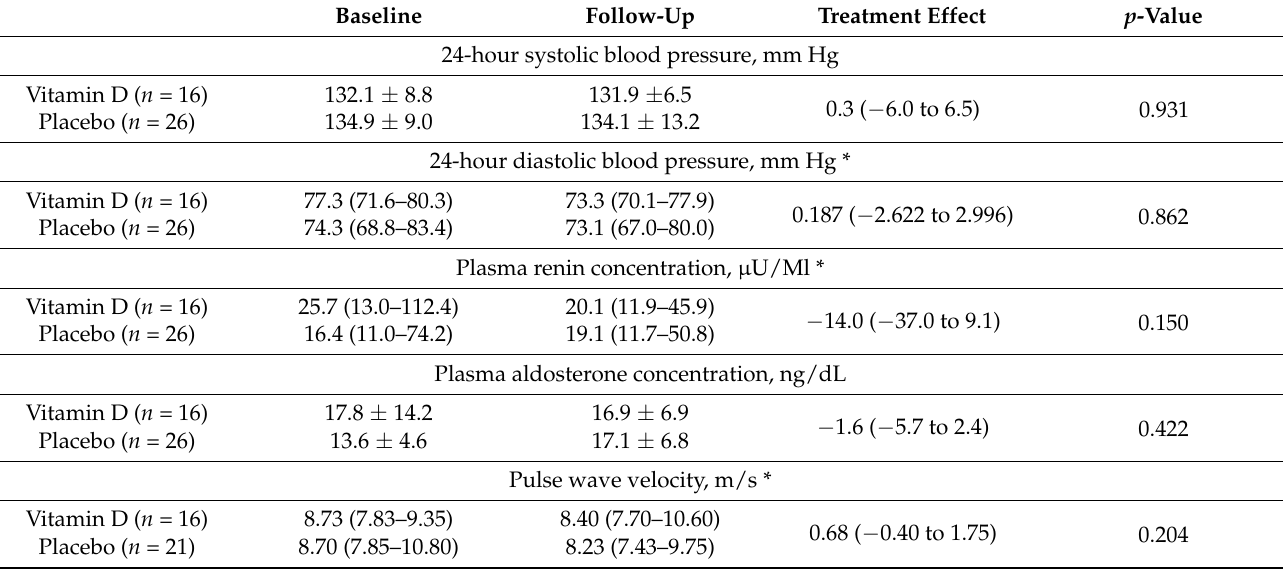
Table 3. Outcome variables at baseline and follow-up and treatment effects in 42 study participants with 25(OH)D < 16 ng/mL who completed the trial (of 45 participants with 25(OH)D < 16 ng/mL who had initially been randomized).